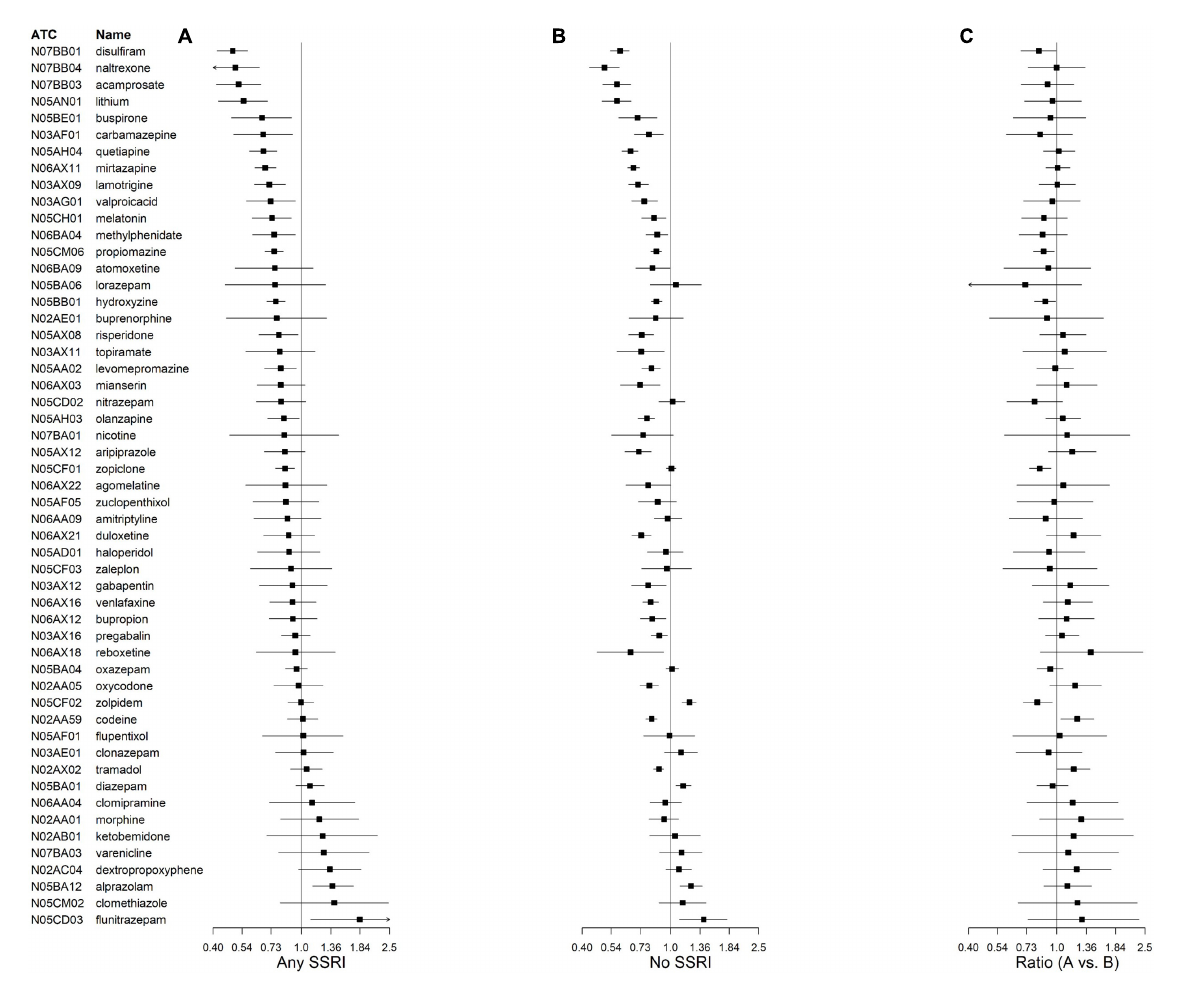
FIGURE2 Incidence rate ratios (IRRs) and credible intervals of suicidal behavior associated with central nervous system (CNS) drug initiation during treatment with (A) and without (B) any selective serotonin reuptake inhibitor (SSRI). Ratio of IRRs in (A) vs (B) are also presented (C) . N02AA59 represents codeine combinations excluding